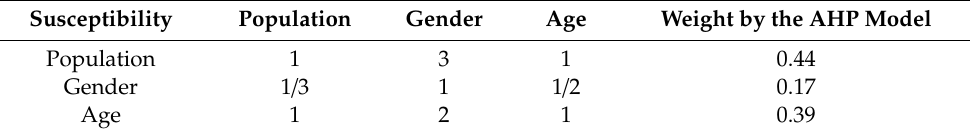
Table 6. The relative importance of susceptibility indicators in Bandar Abbas City .